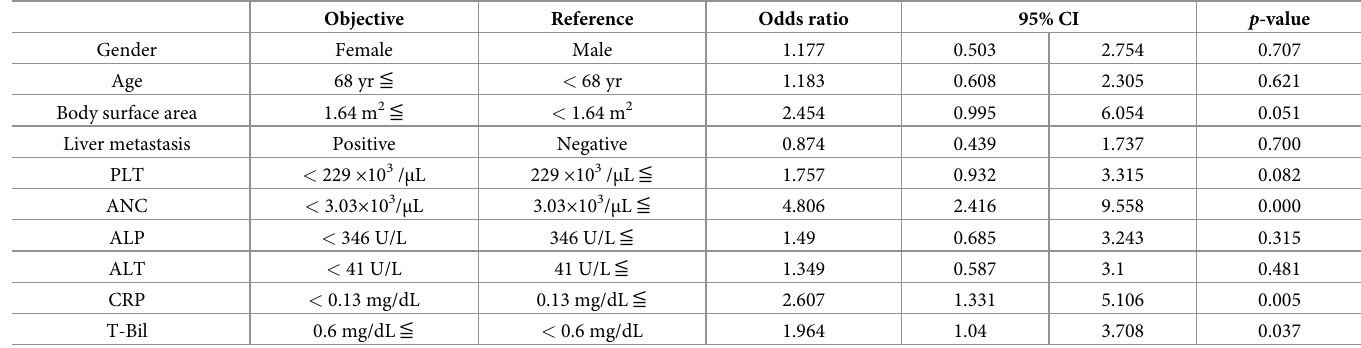
Table 3. Logistic regression analysis of the risk factors of neutropenia Grade 3/4 in patients receiving GnP therapy. Objective